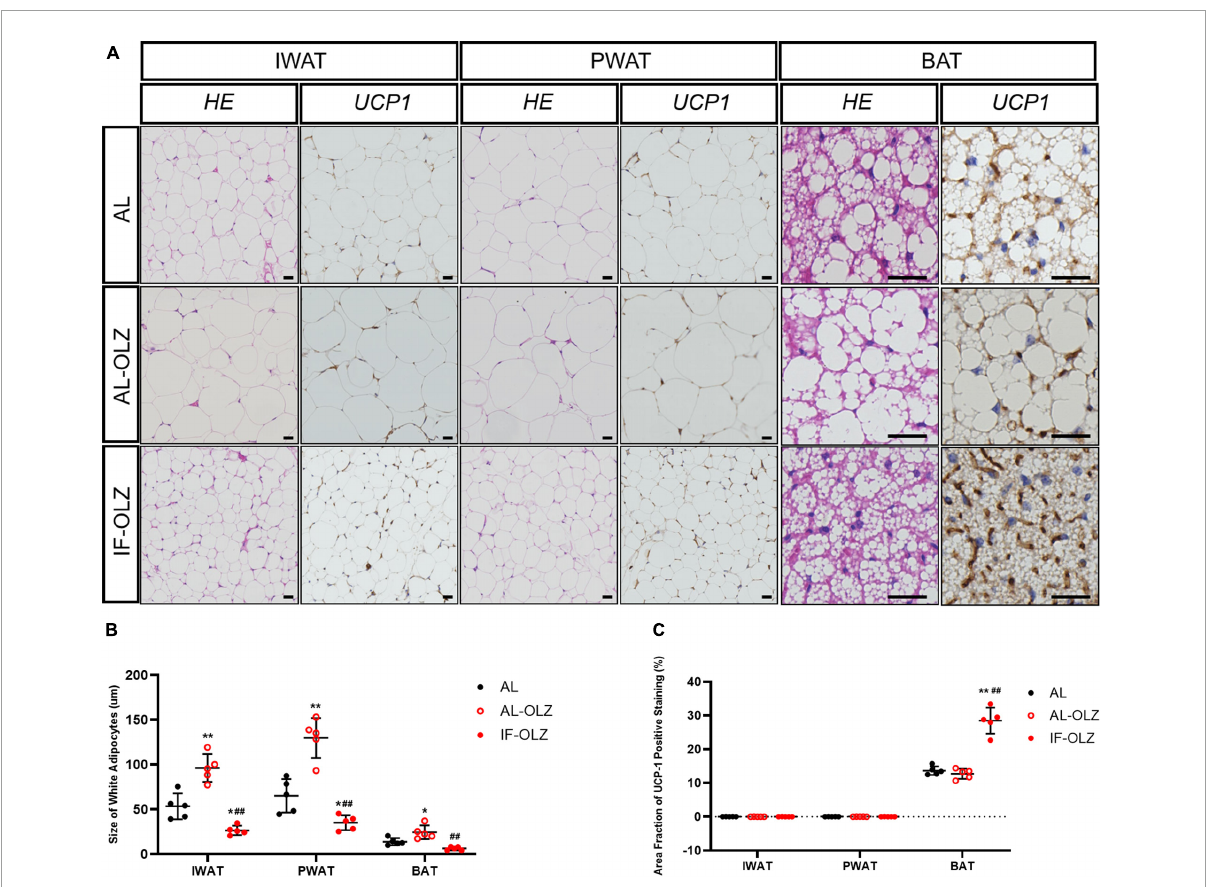
FIGURE3 Adipose tissue pathomorphology and immunohistochemistry. (A) Representative H&E and UCP1 staining of sections of adipose tissues. IWAT, inguinal WAT (subcutaneous); PWAT, perigonadal WAT (visceral); BAT, brown adipose tissue, scale bars: 50 µ m. (B) Average adipocyte sizes in mice from H&E images were measured using ImageJ software. (C) Average area fraction of UCP-1 positive staining (%) in mice from immunohistochemical images were measured using ImageJ software. For each animal group, n = 5. One-way ANOVA plus Tukey’s test was performed for the data analysis. Mean ± SD. * P < 0.05 and ** P < 0.01 versus AL; ## P < 0.01 versus